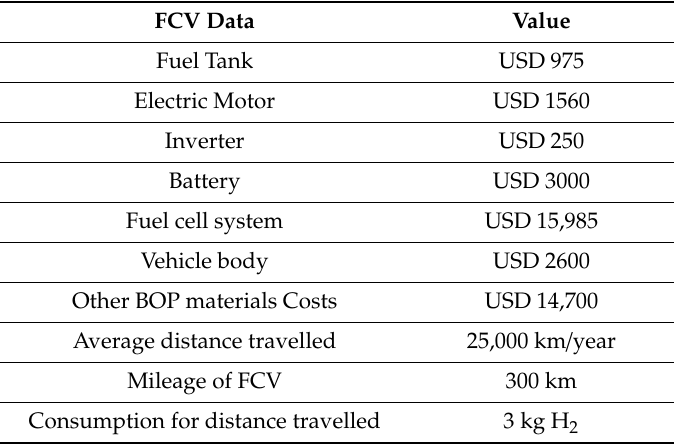
Table A6. Fuel Cell Vehicle Data